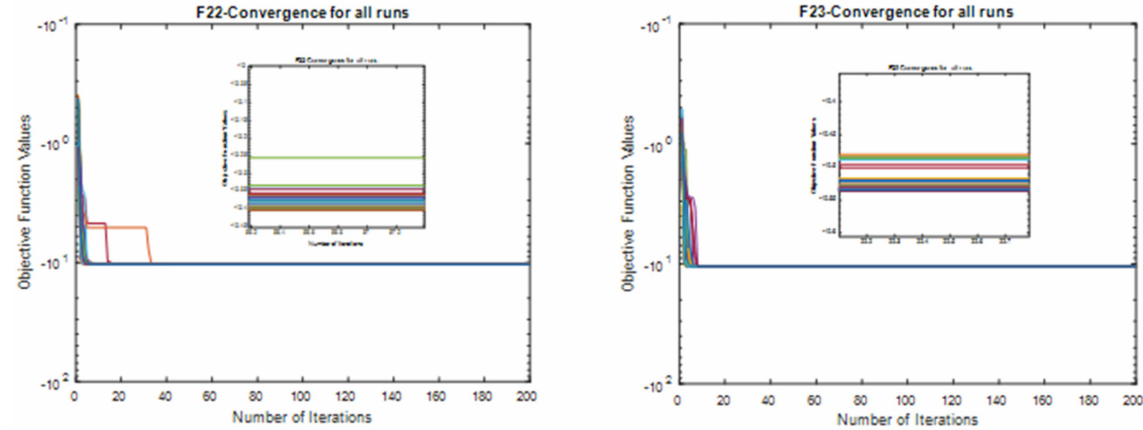
Figure 13. Convergence of MAO over 50 trials for fixed-dimensional variables.